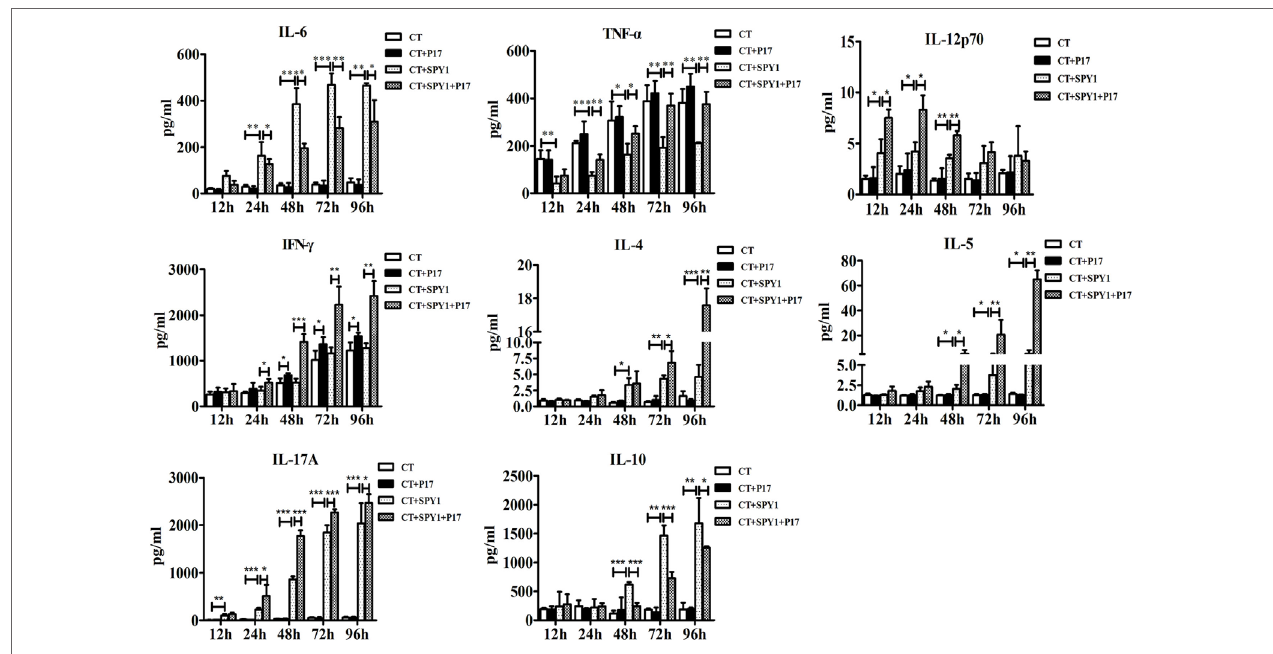
FigUre 2 | P17 treatment strikes the balance among systemic protective immune responses triggered by SPY1 vaccination. On day 7 after the last immunization, mice splenocytes were isolated and stimulated with 70% ethanol-inactivated SPY1. Splenocytes treated with Concanavalin A served as positive control. Concentrations of cytokines including IL-6, TNF- α , IL-12p70, IFN- γ , IL-4, IL-5, IL-17A, and IL-10 in supernatants of stimulated splenocytes were analyzed by enzyme-linked immunosorbent assay. All data were presented as the mean ± SD of three independent experiments. * p < 0.05; ** p < 0.01; *** p <